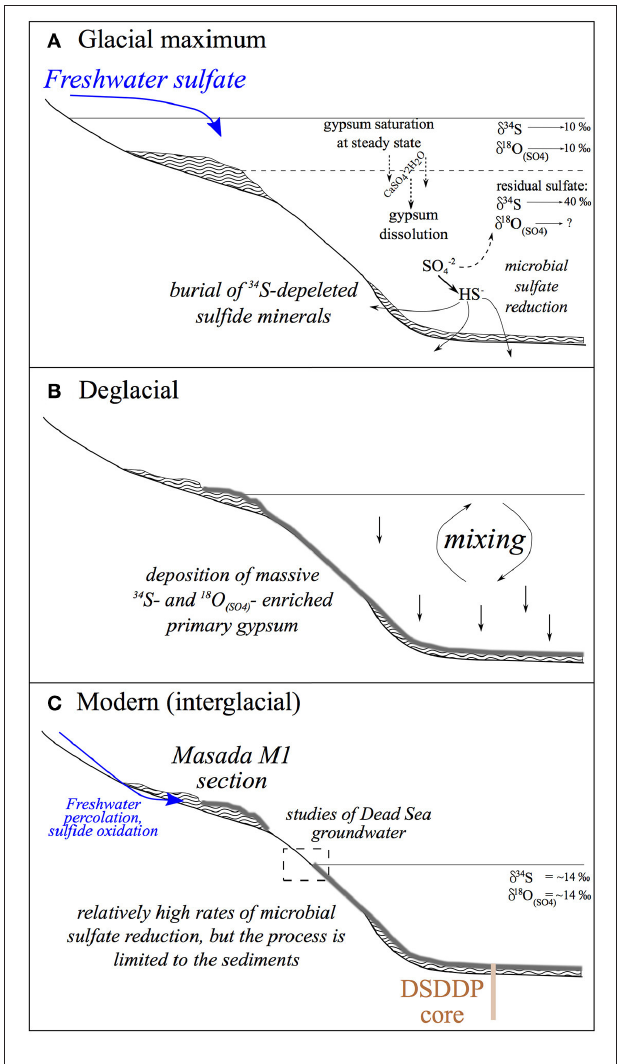
FIGURE 10 | Conceptual evolution patterns of the Dead Sea lacustrine system across Glacial—Interglacial cycles. (A) Glacial—large freshwater influx supports a high stand and density stratification. The overall reservoir of 34 S-enriched sulfate in the lake is highest during the glacial, (B) Deglacial—a regional shift from wet to dry conditions drives a lake level drop that causes water column mixing and massive precipitation of primary gypsum, (C) Modern (interglacial)—dry climatic conditions impose low water stands and a mixed water column. Microbial sulfate reduction is limited to the interstitial zone in the sediments but occurs at faster rates relative to glacial times. Marginal glacial deposits are exposed and occasional freshwater percolation through the sections results in oxidation of sedimentary sulfide to sulfate. These continue to crystalize and form secondary gypsum. This process is unique to the margins and is not recorded in the deep submerged sediments of the